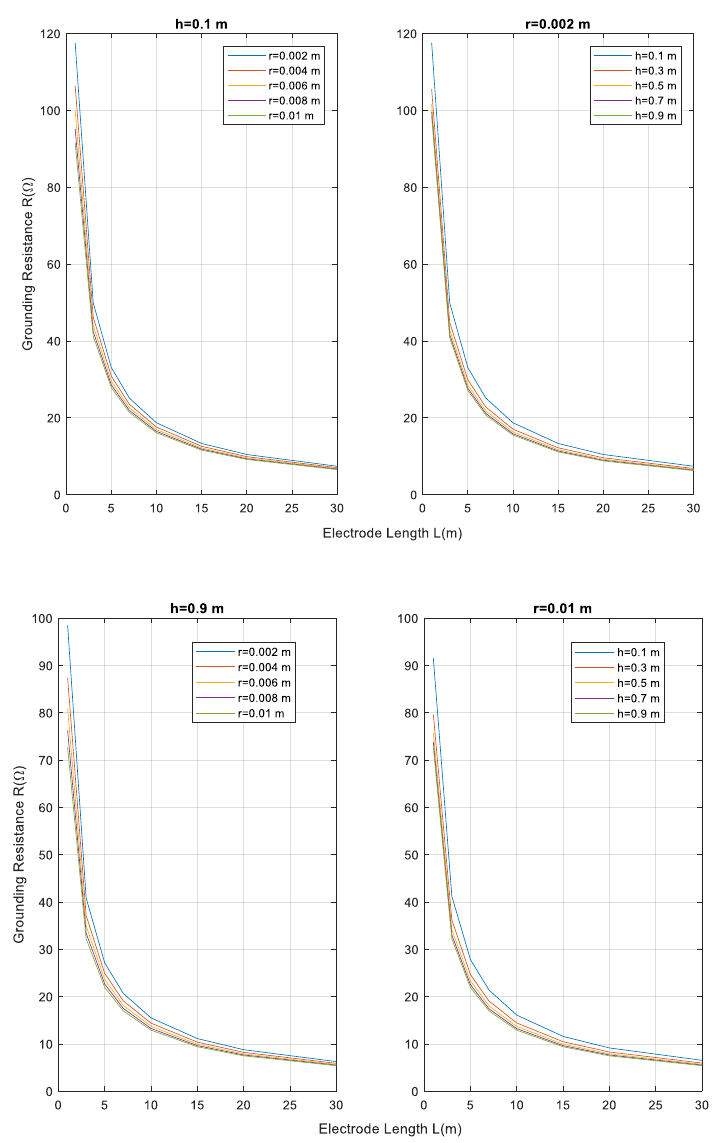
Figure 3. Grounding resistance vs. the electrode length L when h and r take extreme values according to their ranges of variation, as indicated in the text.